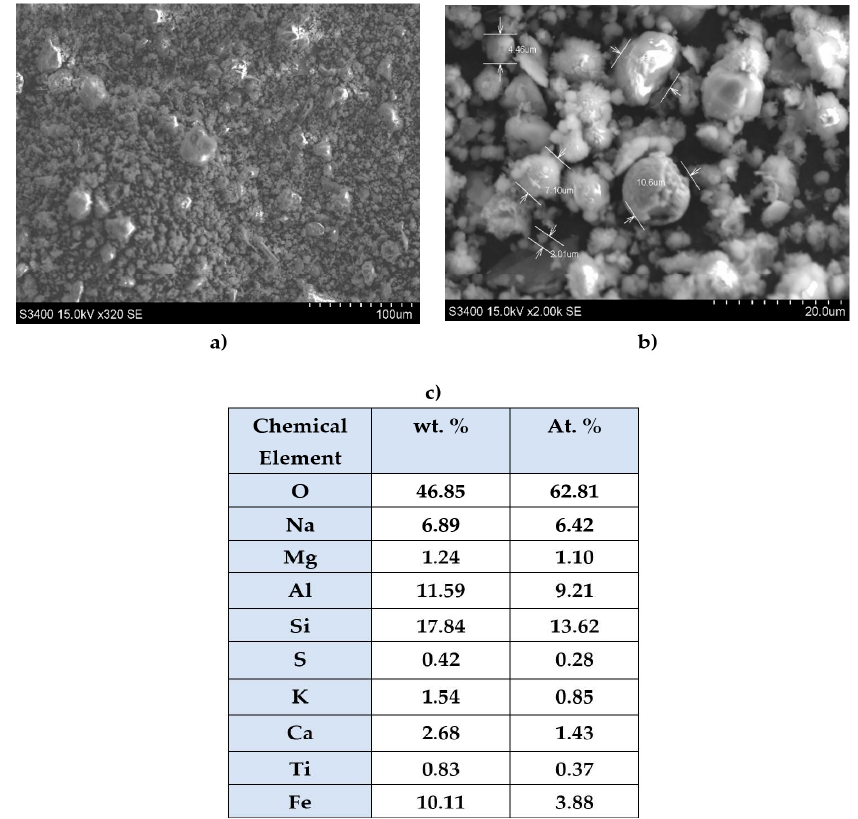
Figure 6. SEM morphology of fly ash ( a , b ) with its chemical elemental composition ( c ). The AFM results revealed a decrease in rugosity (RMS = 106.3 nm) for the pristine FA composite (1S_FA—2) compared to the composite without FA (1S. RMS = 127 nm),